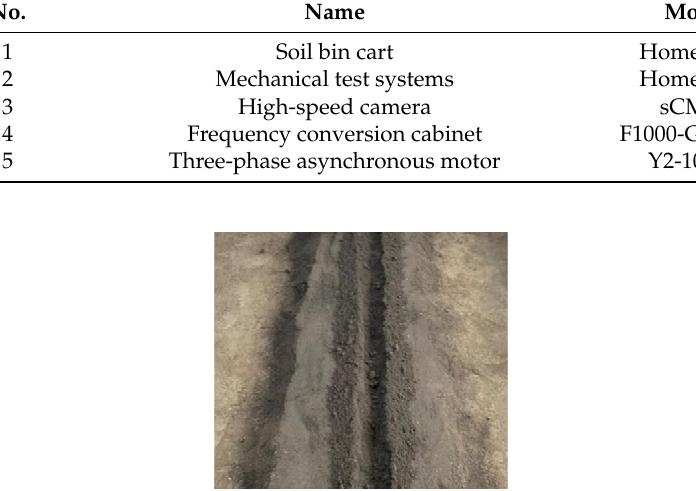
Figure 11. Su 3 experiment of soil bin.